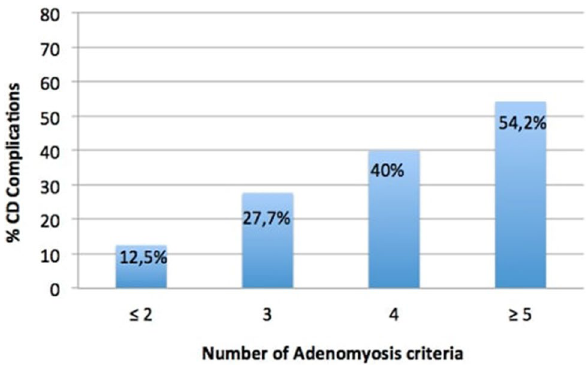
Figure 1. Association between adenomyosis criteria and surgical complications.